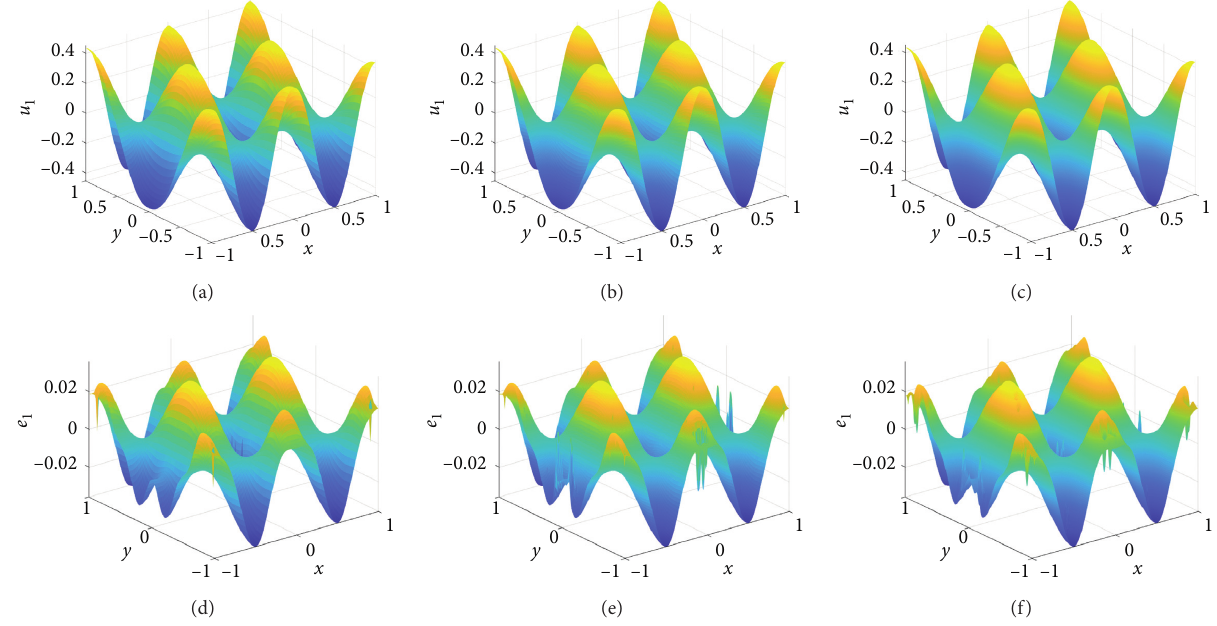
Figure 10: Numerical solutions for u The image I represents the numerical solution obtained with the mesh resolution ( Δ t, Δ x � Δ y ) � ( 0 . 25 , 0 . 02/2 ℓ − 1 ) and I ℓ . (a) ( I 1 ). (b) ( I 2 ). (c) ( I 3 ). (d) ( I error of I ℓ